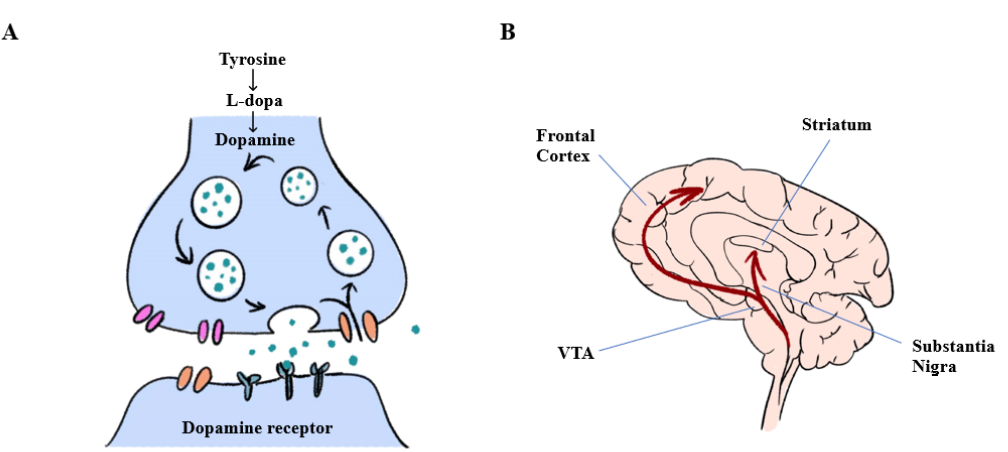
Figure 1. Pathway of dopamine biosynthesis in dopaminergic neurons and dopamine release in the brain. ( A ) Enzymes for the biosynthesis of dopamine are specifically expressed in midbrain dopaminergic neurons. Tyrosine hydroxylase (TH) converts tyrosine to L-dopa, which is further converted to dopamine by aromatic L-amino acid decarboxylase. ( B ) Dopamine pathways in the central nervous system. VTA: ventral tegmental